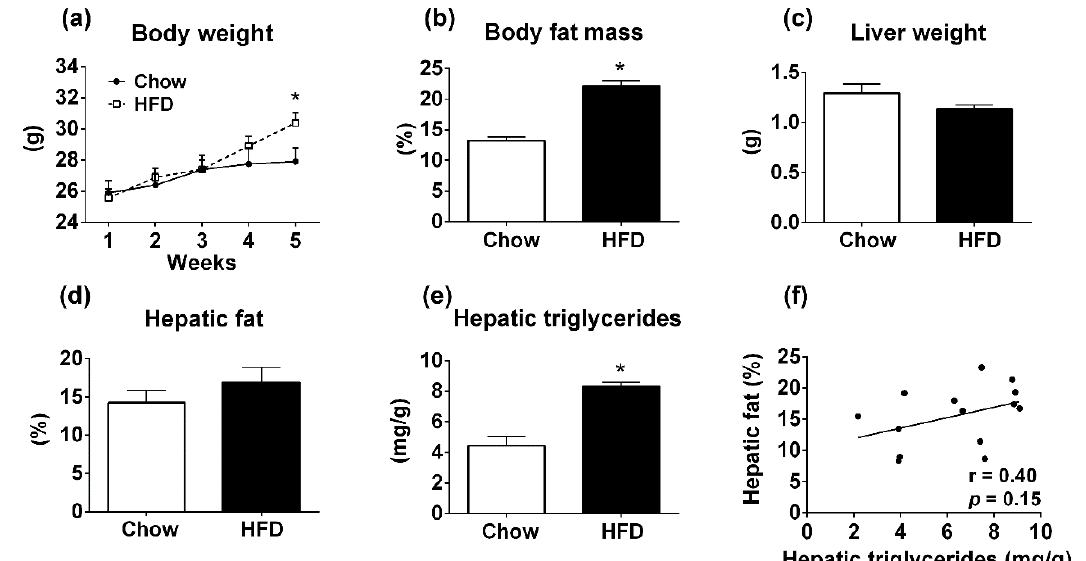
Figure 3. Metabolic parameters of C57BL/6 mice consuming normal chow or HFD for 4 weeks. (a) Body weight (chow group, n = 7; HFD group, n = 7). (b) Body fat mass determined by TD-NMR. (c) Liver weight. (d) Percentage of hepatic fat measured by TD-NMR. (e) Hepatic TAG measured by calorimetric assay. (f) Linear correlation between hepatic fat measured by TD-NMR and hepatic TAG determined by colorimetric assay. * p < 0.05 versus WT group (Student’s t -test).